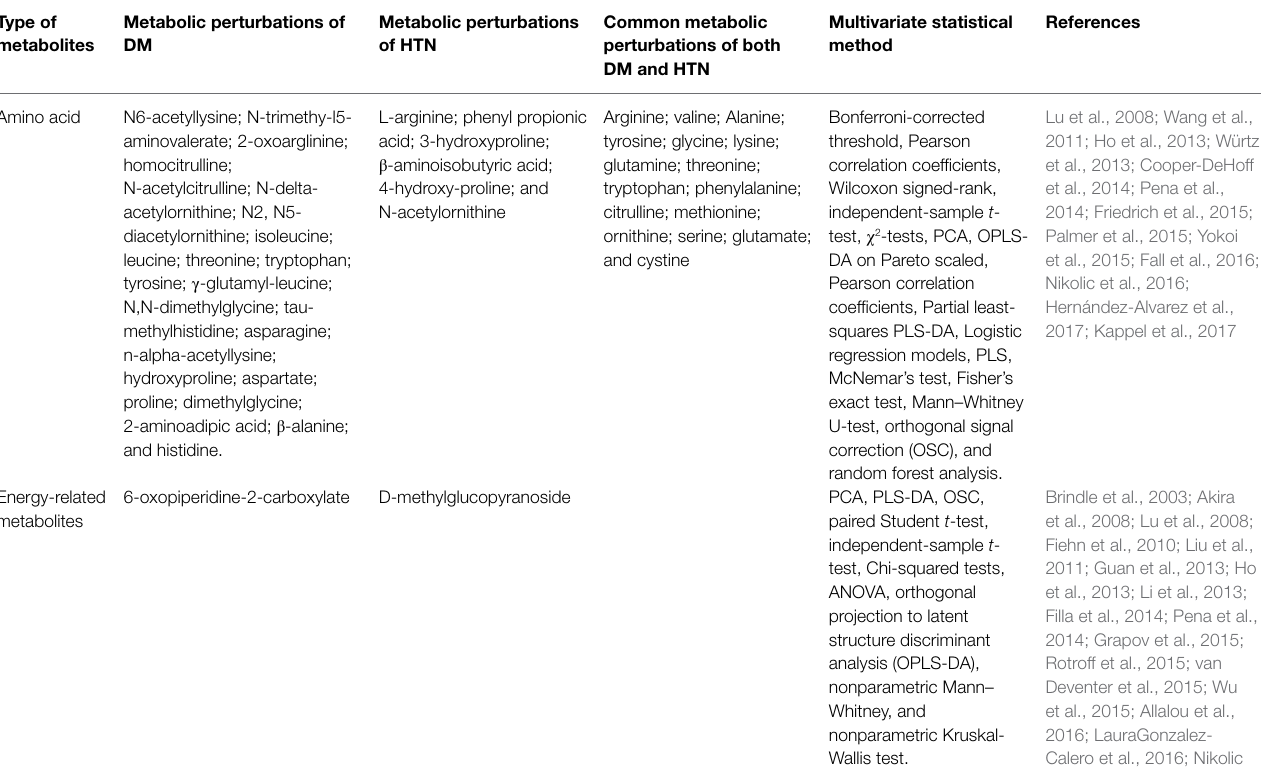
TABLE 1 | Summary of metabolic perturbations of DM and